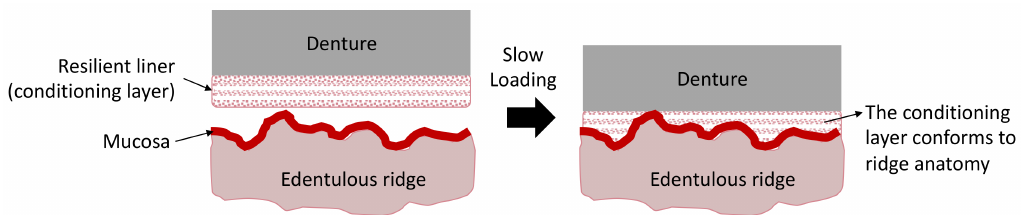
Figure 2. Schematic representation of the loading of the conditioning layer onto the ridge anatomy. The figure is redrawn with modifications from https://pocketdentistry.com/23-denture-liners/, accessed online on 14 November